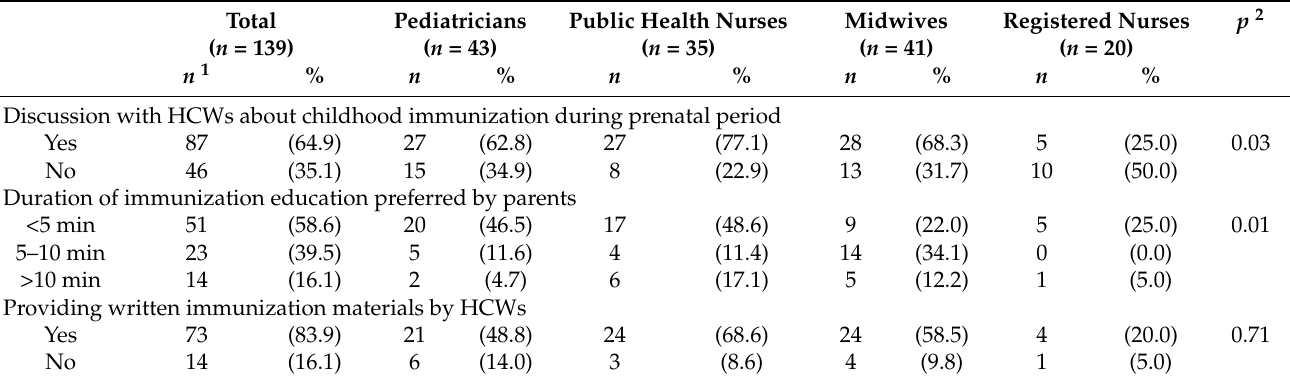
Table 2. Immunization education provided by each healthcare